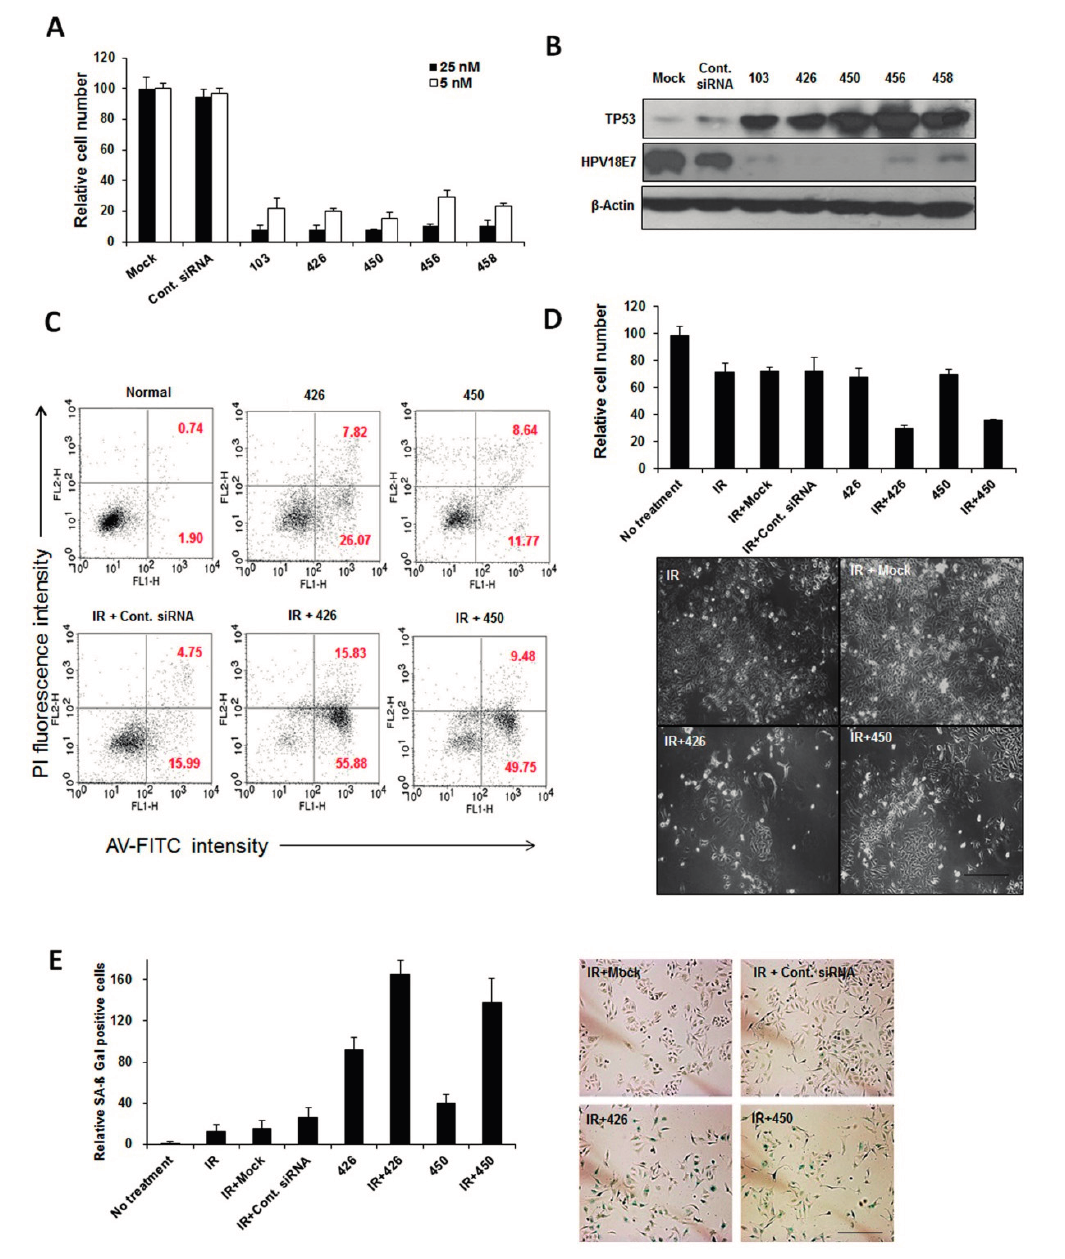
Figure 1. Screening and systematic analysis of HPV18 E6/E7-specific siRNA in combination with radiation. ( A ) Trypan blue assay showing the number of viable HeLa cells transfected with library siRNAs (103, 426, 450, 456 and 458). In these studies, HeLa cells were transfected with 5 or 25 nM of each siRNA. The number of cells was compared to reagent alone without siRNAs (mock); ( B ) Changes in TP53 and HPV18 E7 expression levels in HeLa cells following transfection with HPV18 E6/E7-specific library siRNAs were detected by Western blotting. β -actin was used as a loading control; ( C ) Annexin-V binding assay showing the percentage of apoptotic HeLa cells transfected with siRNA 426 or 450 for 28 h or siRNAs in combination with γ -irradiation; ( D ) The effects of E6/E7-specific siRNA 426 or 450 in combination with γ -irradiation on cell viability and morphology are shown. Scale bar: all are 200 μ m; and ( E ) The effect of HPV E6/E7-specific siRNAs alone or combined with γ -irradiation (IR) on cellular senescence, Scale bar: all are 200 μ